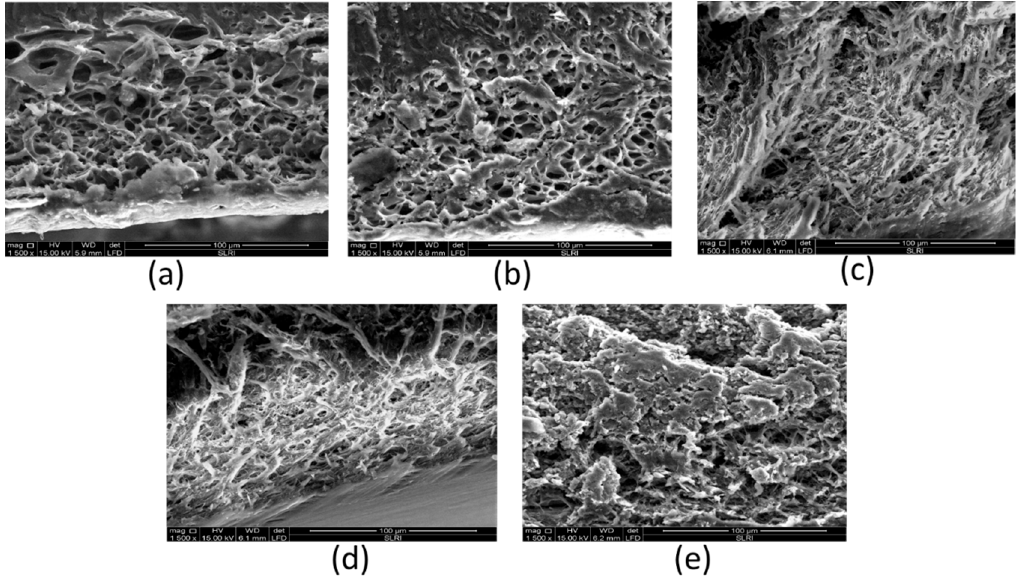
Figure 7. SEM images of cross-section scaffold; SN2 ( a ), SN5 ( b ), SN6 ( c ), SN7 ( d ), and SN8 ( e ).